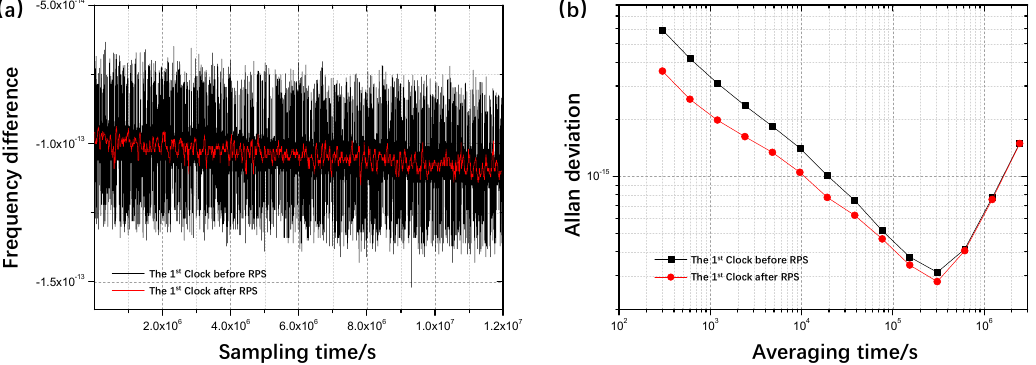
Figure 3. First hydrogen maser and its mirror clock ( a ) and the stability curves ( b ) of this hydrogen maser with jump and its mirror clock in the case of a single clock jump.